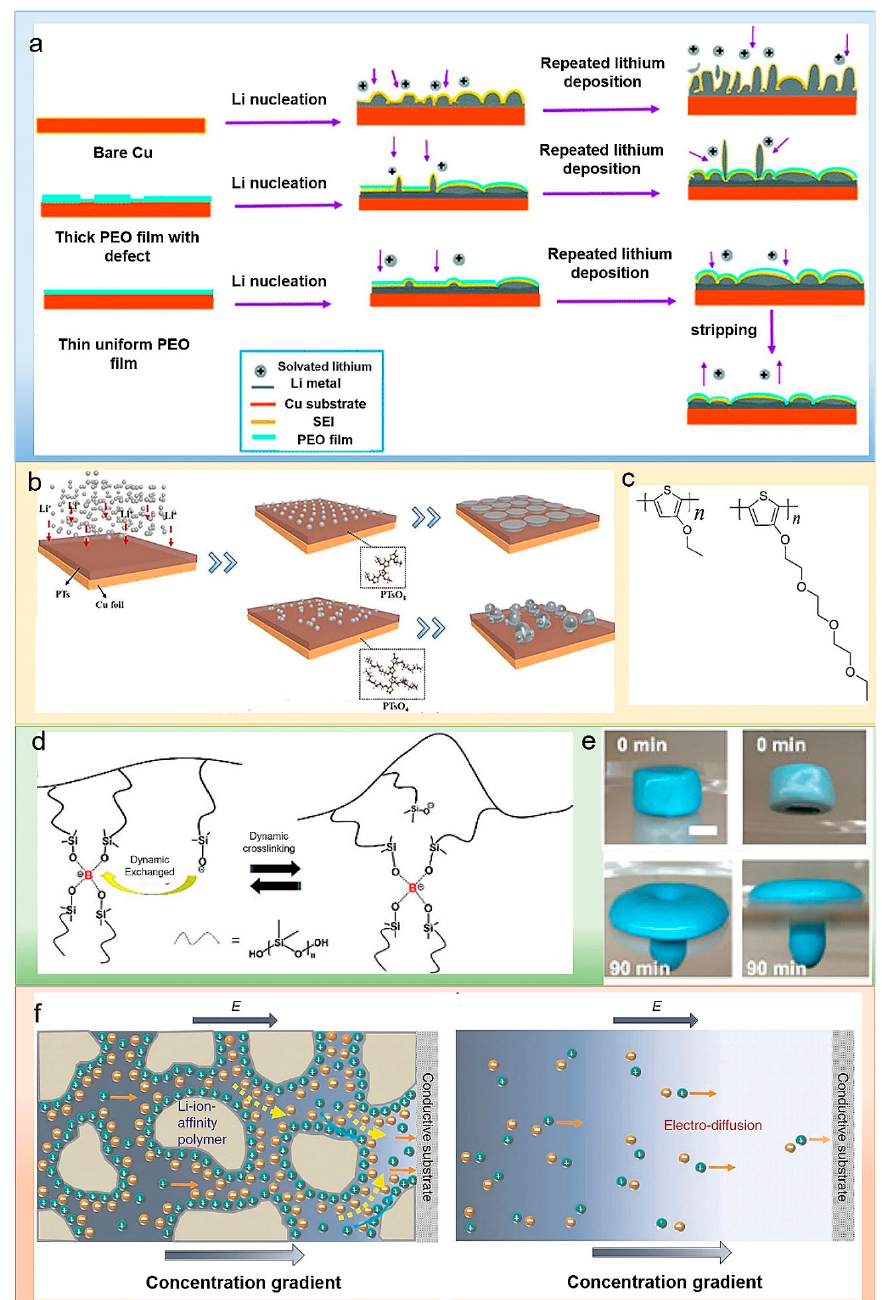
Figure 2. ( a ) Schematic diagrams of Li plating and stripping. Lithium deposited on (top) bare copper electrodes (middle) micro-PEO thin film coating (bottom) with optimized nanoscale PEO thin film coating [29]. Reproduced with permission. Copyright 2018, Royal Chemical Society. ( b ) Schematic diagram of plating uniform lithophilic PTs substrates on Cu foils. ( c ) (Left) Chemical formula of PTsO1, (Right) chemical formula of PTsO4 [35]. Reproduced with permission. Copyright 2021, Elsevier ( d ) Molecular structure of SP. ( e ) Digital pictures of SP mounted over a hole punched on a Petri dish. ( f ) Two front views at different time points [37]. Reproduced with permission. Copyright 2017, American Chemical